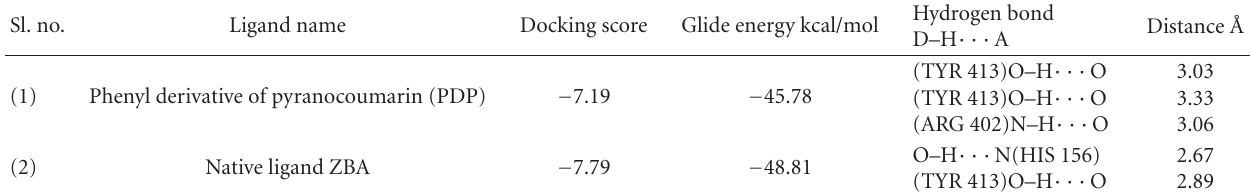
Table 4: IFD results of ligand PDP and native ligand ZBA with the target protein trichothecene 3-O-acetyltransferase. Sl.